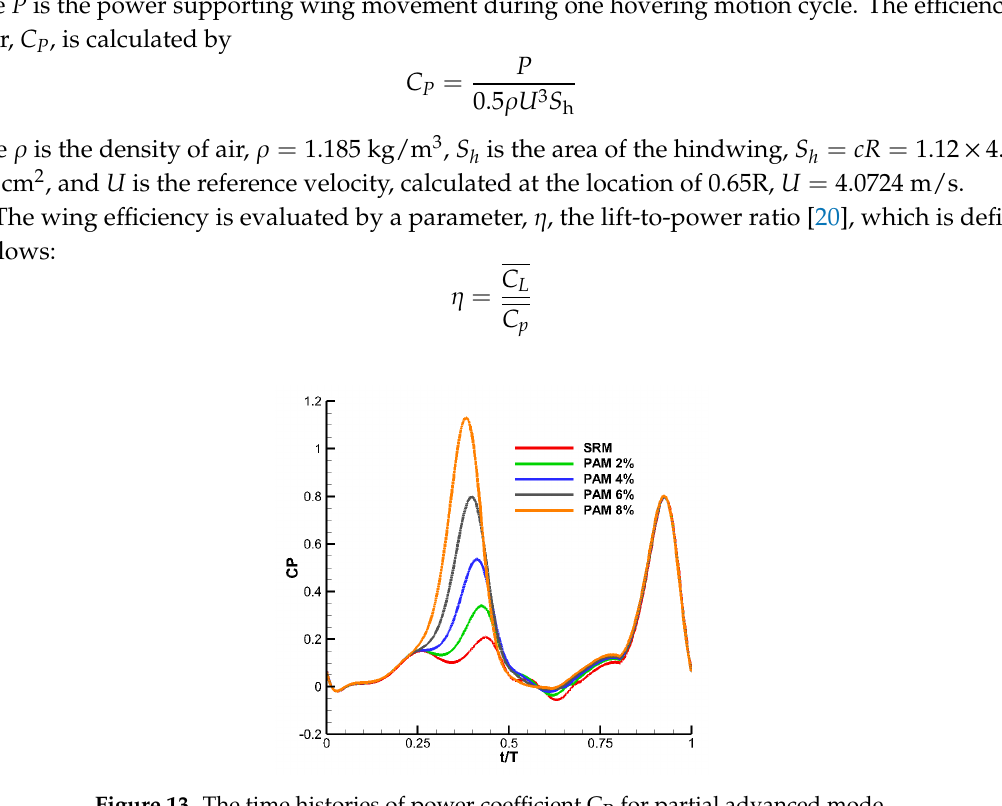
ffi cient C P for partial advanced mode.